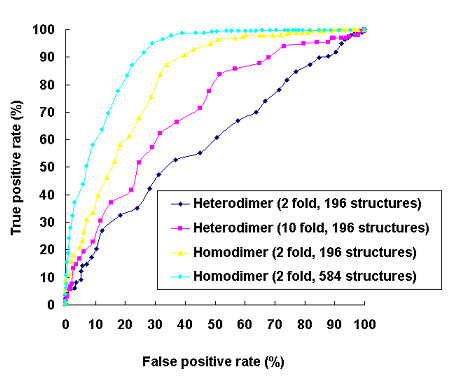
Comparison of the ROC curves for the prediction of interacting and non-interacting protein binding sites between homo-dimer and hetero-dimer interfaces using training data of different sizes.